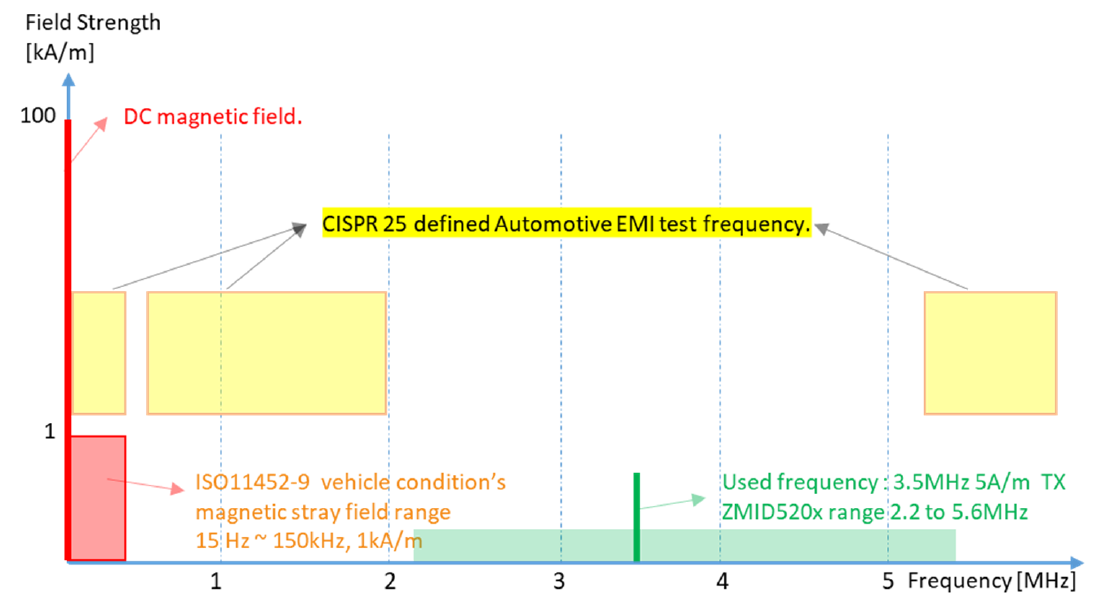
Figure 4. Proposed inductive position sensor excitation frequency of 3.5 MHz (BOLD green pk) compared to the other frequency ranges. CISPR automotive test frequency (yellow), vehicle condi- tion’s external magnetic field range (red), and ZMID 520 × IPS sensor’s possible tuning frequency range (green).